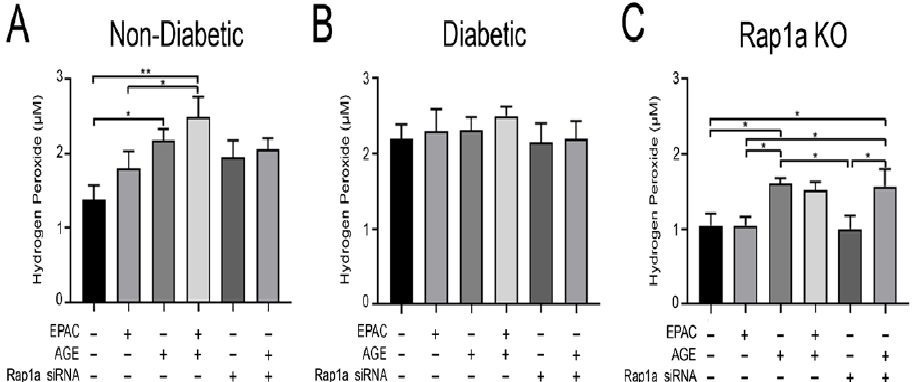
Figure 6. AGE/RAGE signaling induced elevated levels of hydrogen peroxide in non-diabetic and Rap1a KO cardiac fibroblasts. Cardiac fibroblasts isolated from ( A ) non-diabetic, ( B ) diabetic, and ( C ) Rap1a KO mice were treated with different combinations of pharmacological modifiers: EPAC (100 µM), exogenous AGEs (0.5 mg/mL), and Rap1a siRNA (100 nM). Cell lysates were collected and assessed for concentration of hydrogen peroxide. Values graphed are mean ± SEM (n = 4–13) and a one-way ANOVA followed by a Fisher’s protected least significant difference post hoc was conducted to determine significance (* p < 0.05 and ** p < 0.01).